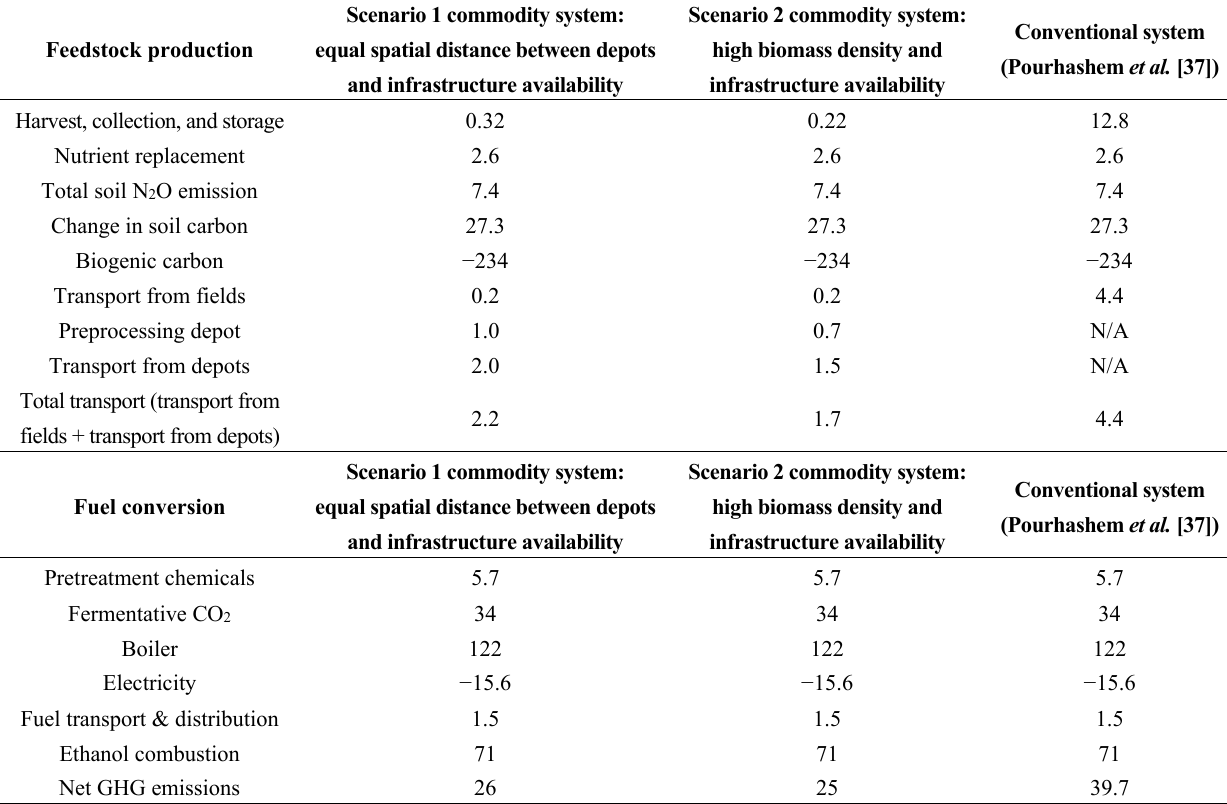
Table 3. Scenarios 1 and 2 weighted average greenhouse gas (GHG) emissions sources and sinks of life cycle components: (1) feedstock production ( i.e. , crop production including nutrient replacement and soil GHG emissions); (2) feedstock harvest,